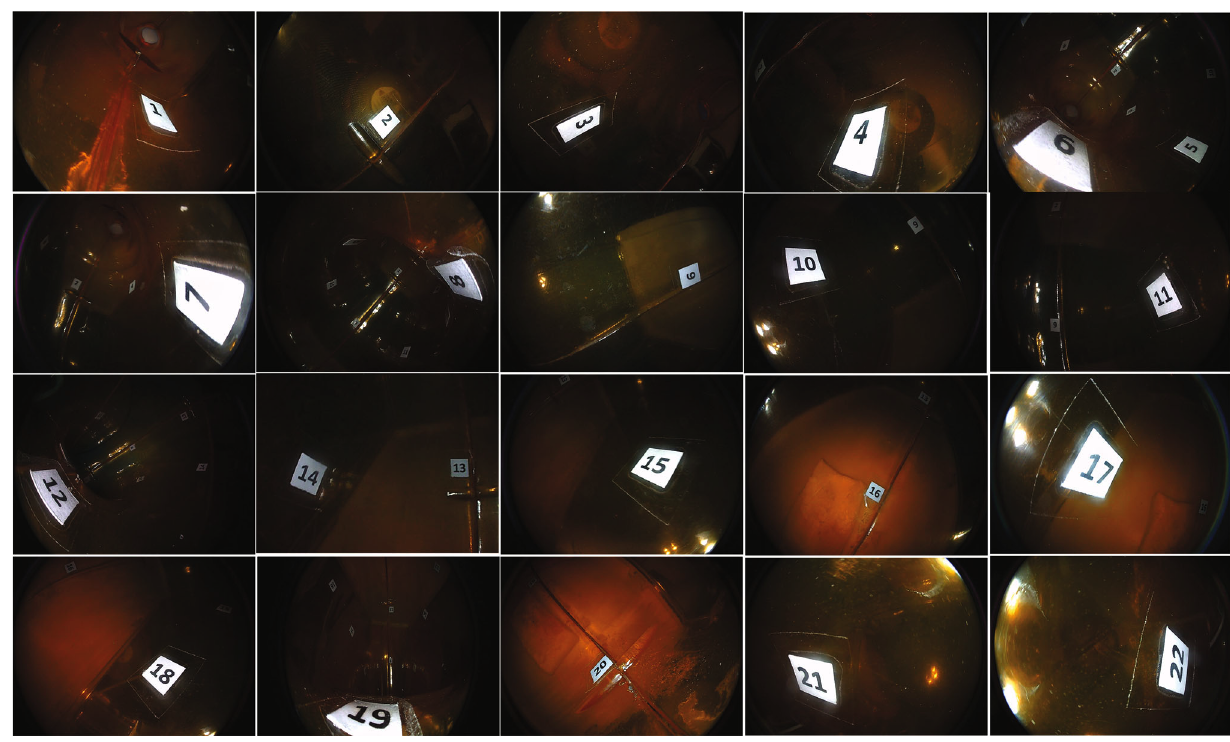
Figure 3: Images taken by MCCCE in the plastic stomach